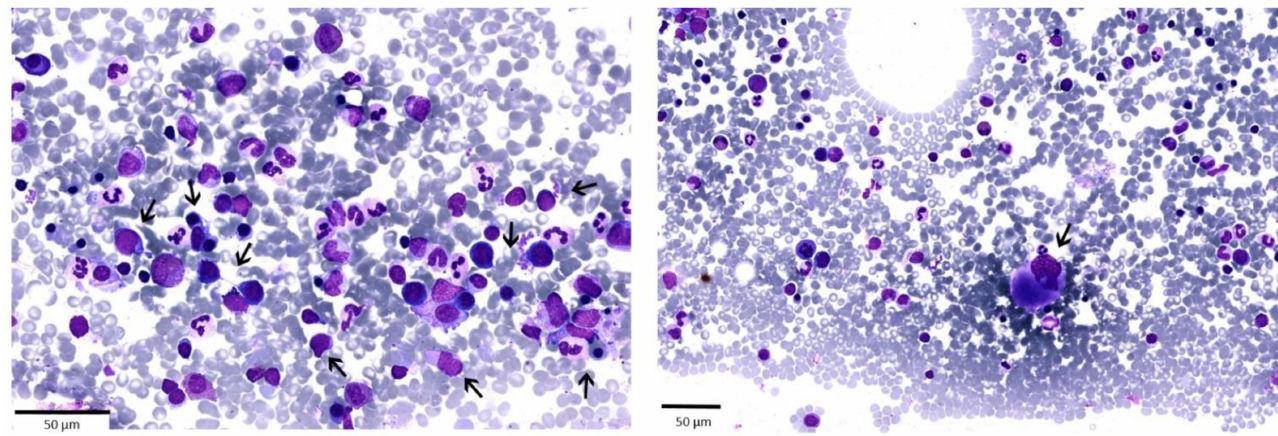
Figure 2. Bone marrow aspirate of the patient presenting with neutropenia and carrying TERT mutations. The bone marrow smear (May-Grünwald-Giemsa) staining shows morphological abnormalities in erythroid lineage (cytoplasmic vacuolization, cytoplasmic bridges, pyknosis, incomplete hemoglobinization); myeloid dysplastic features (increased myeloblasts, neutrophil hypogranulation) and megakaryocytes dysplasia (hypolobulated megakaryocytes). Black arrows point to the main dysplastic